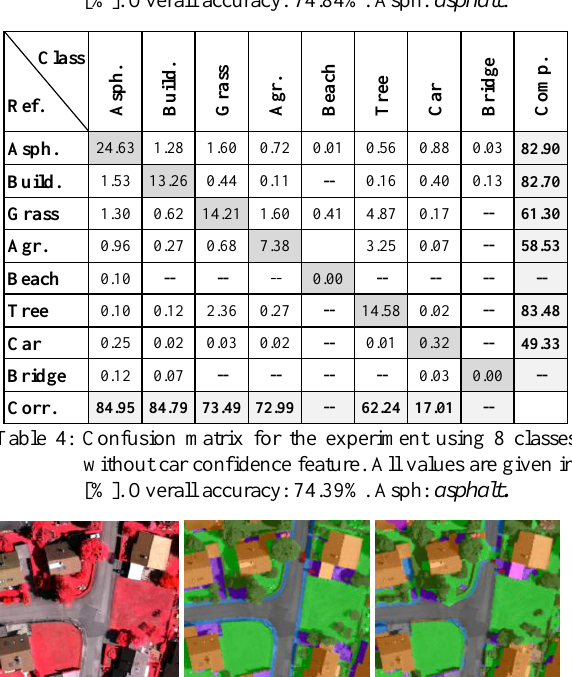
Figure 2: Classification results. Left: original orthophoto; centre: ground truth superimposed to the intensity mage; right: results achieved with 14 classes and the car feature superimposed to the intensity